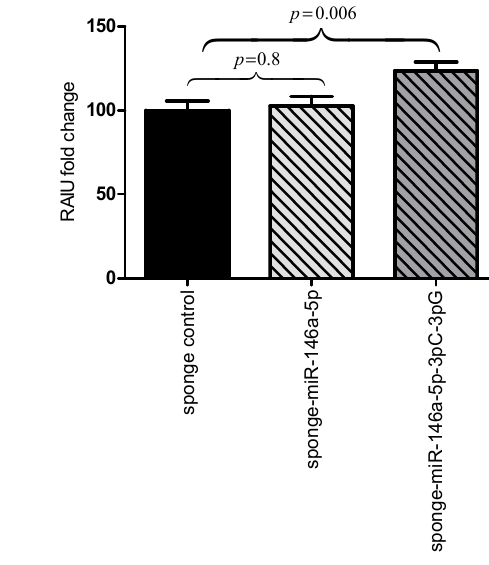
Figure 2. Positions of the putative miRNA binding sites in 3’UTRs of SLC5A5 , identified by TargetScan and miRanda. Nucleotides of perfect complementarity are shown as a seed match ( A ) and the rs2910164 is indicated in red. ( B ) The effect of miR-146a-5p-3p^C or miR-146a-5p-3p^G on the luciferase activity mediated from the NIS 3 ′ UTR is shown relative to control (cells transfected with control miR). The results are normalized to Renilla luciferase and derived from three experiments, each performed in triplicates. Binding of microRNAs to the 3 ′ UTR of NIS resulted in a significant reduction in the luciferase activity for miR-146a-5p-3p^C (22%, p = 0.0001) and miR-146a-5p-3p^G (17%, p = 0.0004). The graphs show the mean, along with deviations from mean (SEM). Statistical analysis was performed using an unpaired t test.